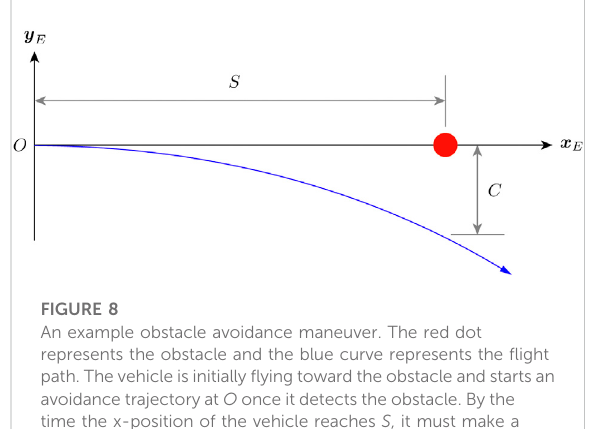
FIGURE 8 An example obstacle avoidance maneuver. The red dot represents the obstacle and the blue curve represents the fl ight path. The vehicle is initially fl ying toward the obstacle and starts an avoidance trajectory at O once it detects the obstacle. By the time the x-position of the vehicle reaches S , it must make a minimum of C y-direction clearance with the